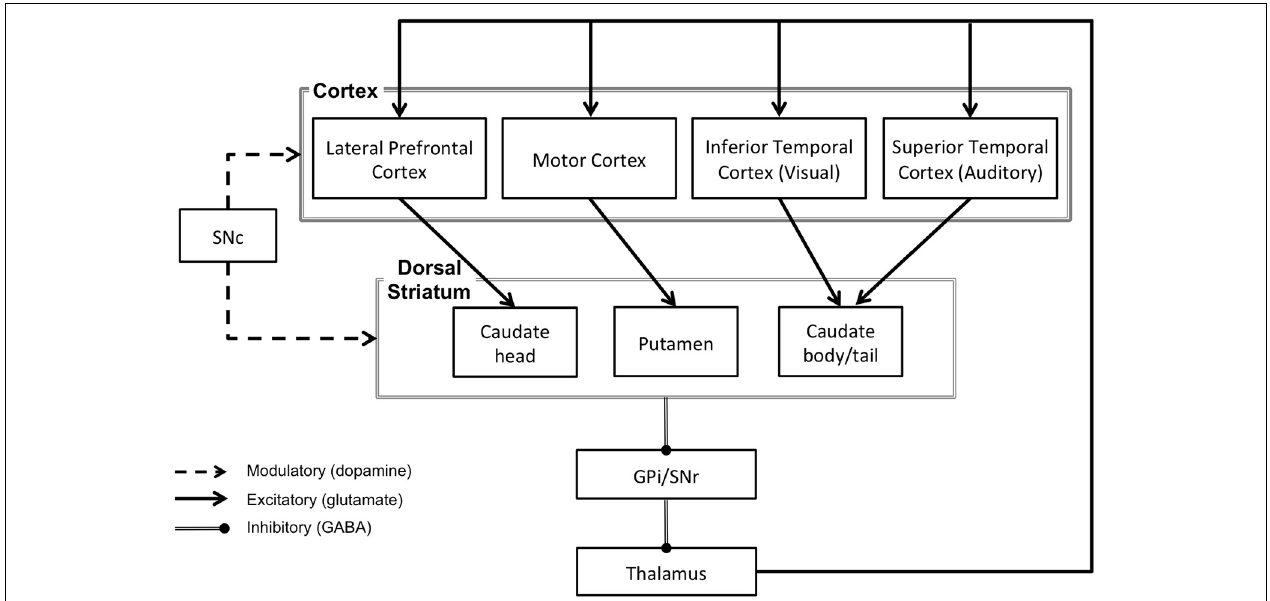
FIGURE 2 | The direct pathway circuitry of the basal ganglia via the dorsal striatum. SNc, substantia nigra pars compacta; SNr, substantia nigra pars reticulata; GPi, globus pallidus, internal